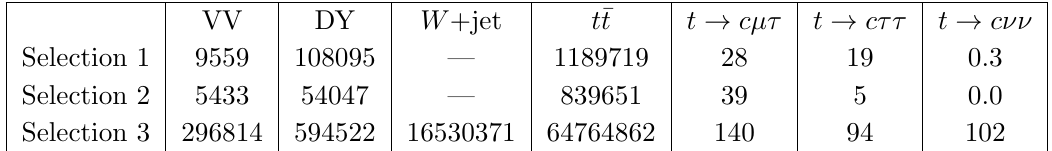
Table 2 . The number of signal and background events after selections at 13 TeV LHC with inte- grated luminosity of 3000 fb (cid:0) 1 . The signals are the t (cid:22) t events with one top quark decaying leptonically and the other one decaying though t c(cid:22)(cid:28) , t c(cid:28)(cid:28) and t c(cid:23)(cid:23) induced by our LQ scenarios of ! ! ! explaining R with a universal benchmark BR 10 (cid:0) 6 . The W +jet events in Selection 1 and 2 D ( (cid:3) ) (cid:24) are negligible because of low statistics after the requirement of b and (cid:28)